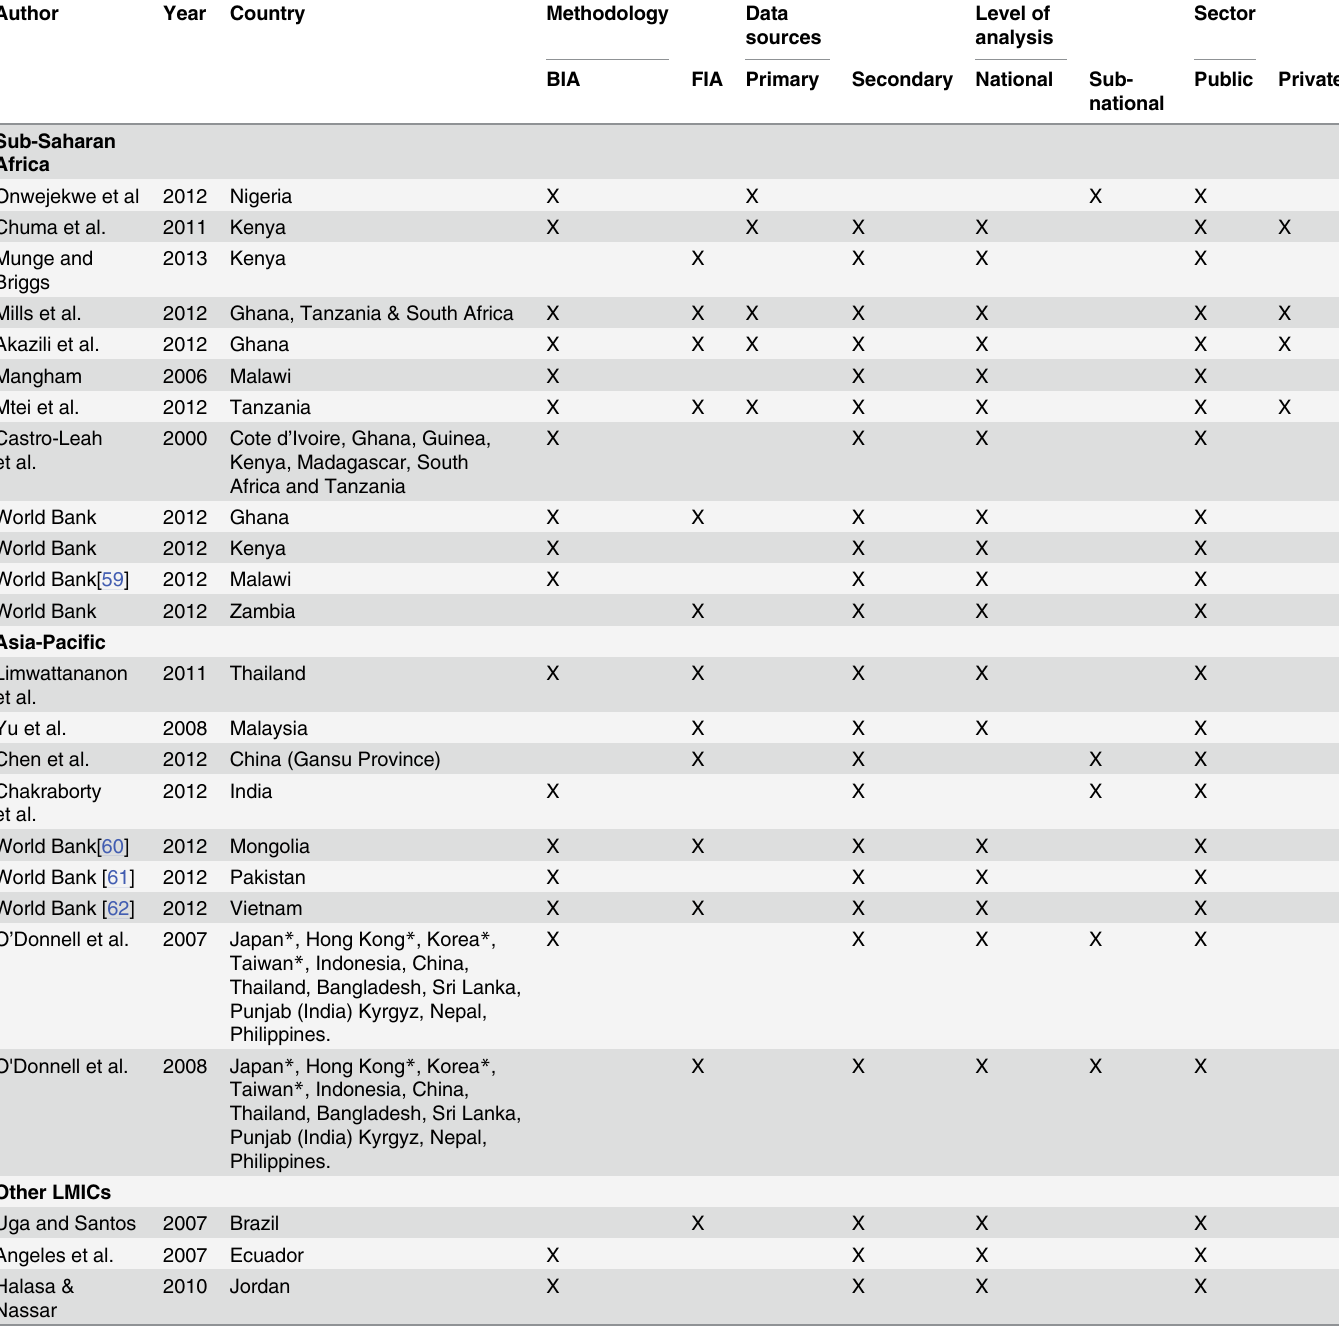
Table 2. Characteristics of studies included in the